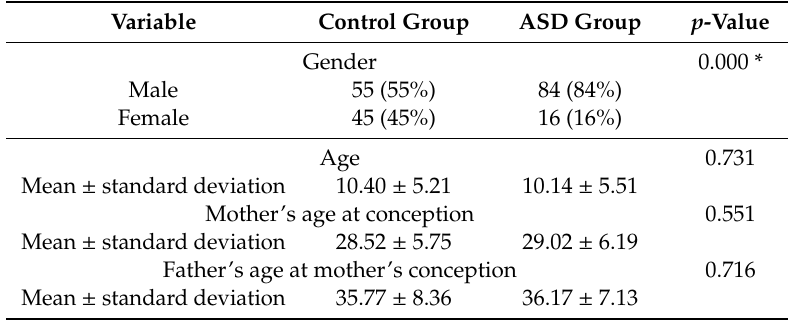
Table 1. Demographic characteristics of control and Autism Spectrum Disorders (ASD)